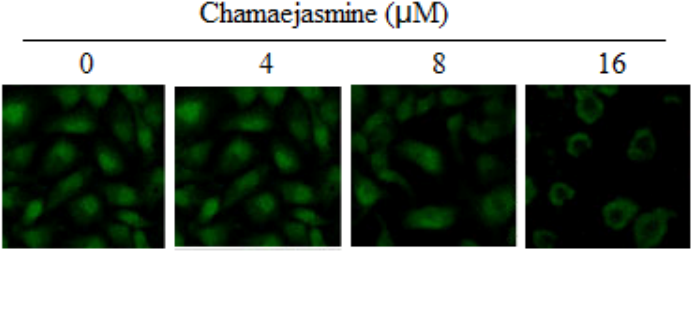
Figure 6. Immunofluorescence analysis of NF- κ B (p65 subunit) localization in the